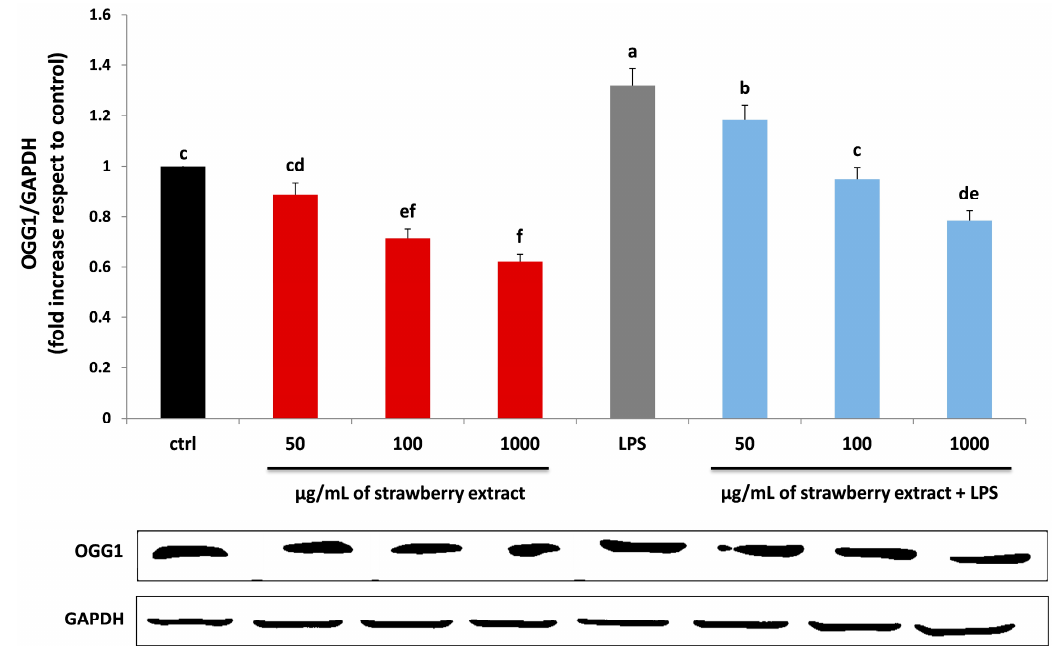
Figure 6. Level of protein related to DNA damage (OGG1) in HDF cells treated with different concentrations of strawberry extracts (50, 100, 1000 µg/mL) for 24 h (red bars), LPS (10 µg/mL) for 24 h (grey bar) and with different concentrations of strawberry extracts and then with LPS (blue bars). Black bar represent the control group. Data are expressed as mean values ± SD. Columns with different superscript letters are significantly different ( p < 0.05).